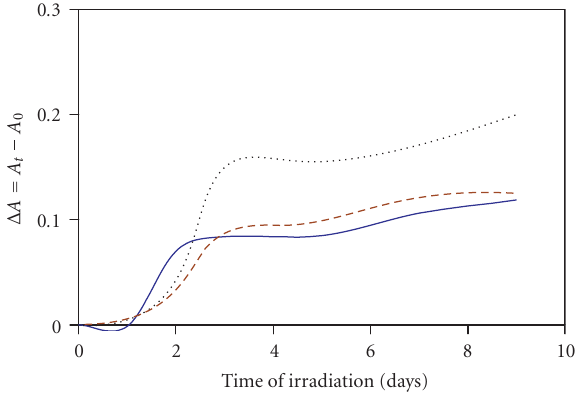
Figure 2: The changes of absorbance at 275nm during solar irradiation of collagen (solid curve), collagen/PVA (dashed curve), and colla- gen/PVP films (dotted curve), key to time and dose of solar radiation in Table 1.